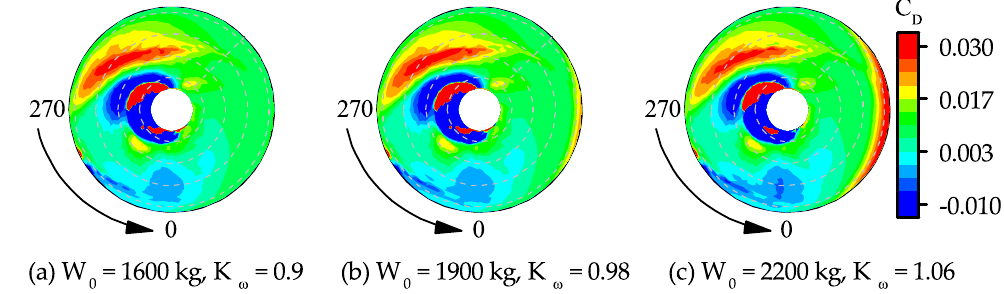
Figure 11. µ = 0.3, drag coefficient, C D , with rotor